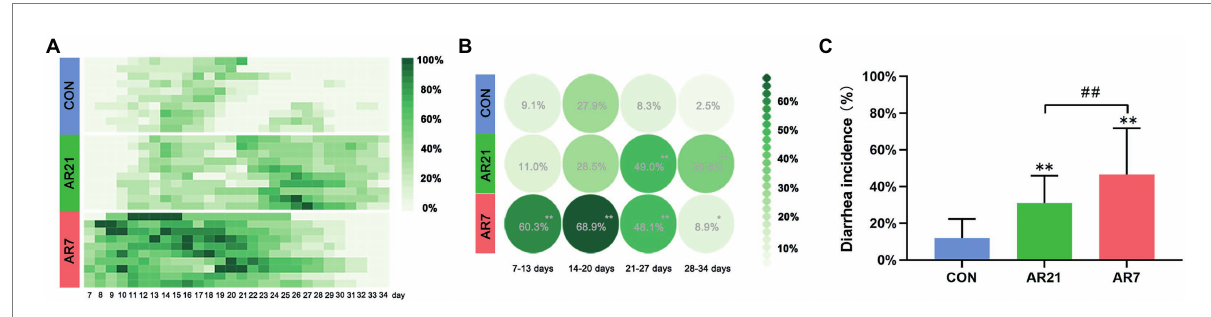
FIGURE 1 Effects of artificial rearing on the diarrhea incidence in piglets. (A) Recorded diarrhea occurrence of piglets from day 7 to day 34. (B) Mean diarrhea incidences of piglets for each week. (C) Mean diarrhea incidences of piglets from day 7 to day 34. Data are presented with mean ± SD. ** p < 0.01 versus the CON group; ## p < 0.01 versus the AR21 group. n = 10